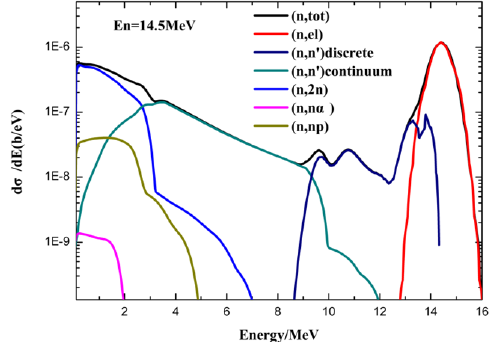
Fig.11 The distributions of leakage neutron spectra from different reactions for nat Fe(Retrieved from the CENDL-3.1 library) .